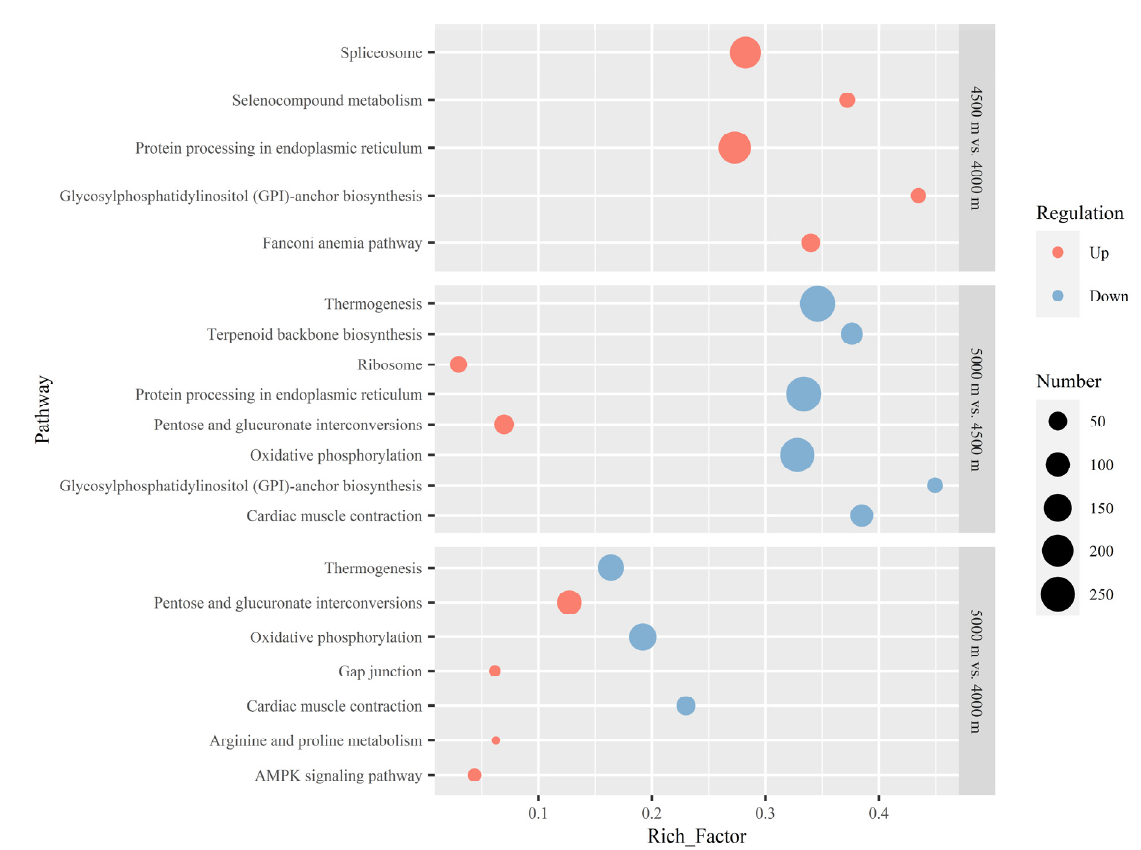
Figure 2. Pathways enriched by differentially expressed genes (DEGs) of Bombus kashmirensis in the comparisons between different altitudes. All pathways with an adjusted p -value lower than 0.05 are shown for each comparison. No significant down-regulated DEGs were detected in the 4500 m vs. 4000 m comparison; therefore, it is not included in the figure. “Number” denotes the number of DEGs enriched in the pathway. The pathways with red points indicate pathways enriched by up-regulated DEGs, while pathways with blue points are enriched by down-regulated DEGs.